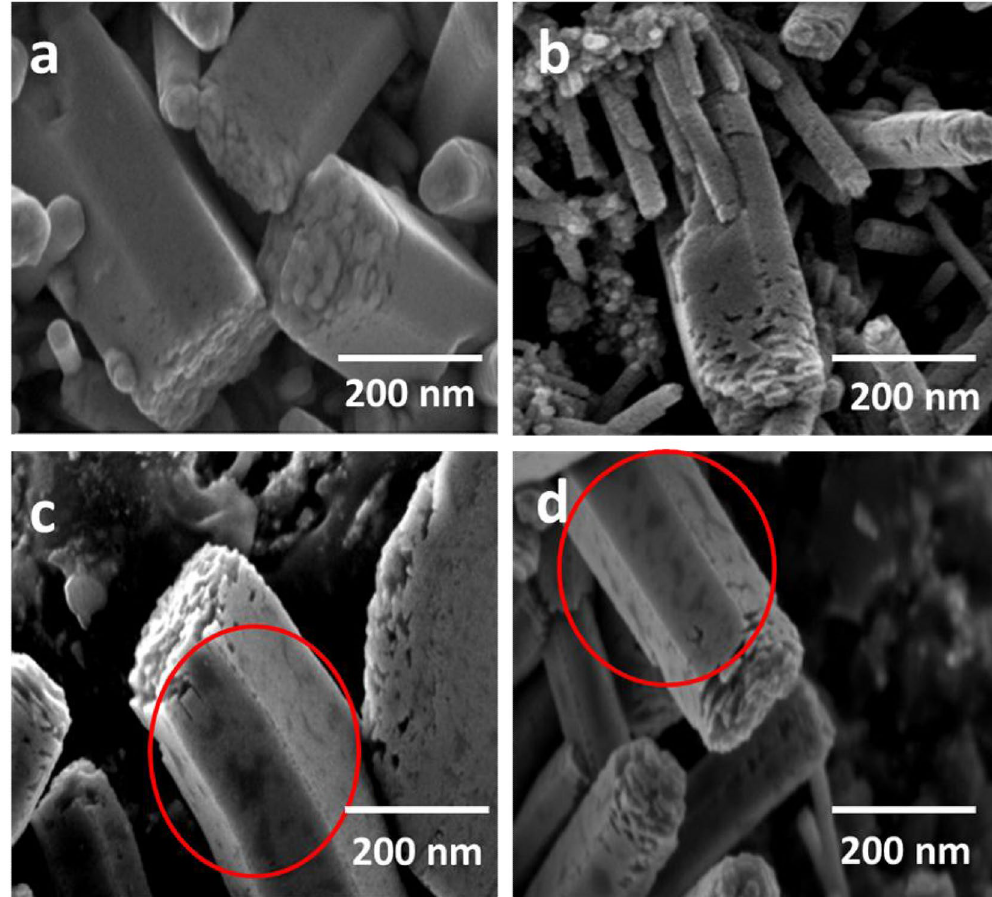
Figure 3. SEM images of the ZnO NRs irradiated under different fluences with 150MeV Ag 11 + ions ( a ) pristine, ( b ) 3E11, ( c ) 7E11 and ( d ) 3E12 ions/cm 2 .The rings in the images indicate randomly distributed darker patches on the surface of the